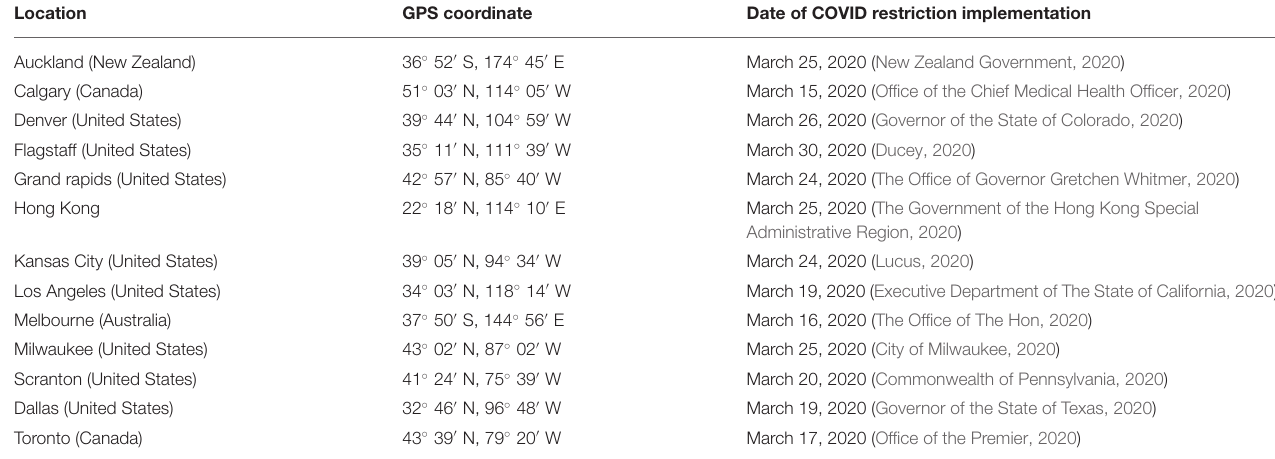
TABLE 1 | Implementation of COVID restrictions at participants’